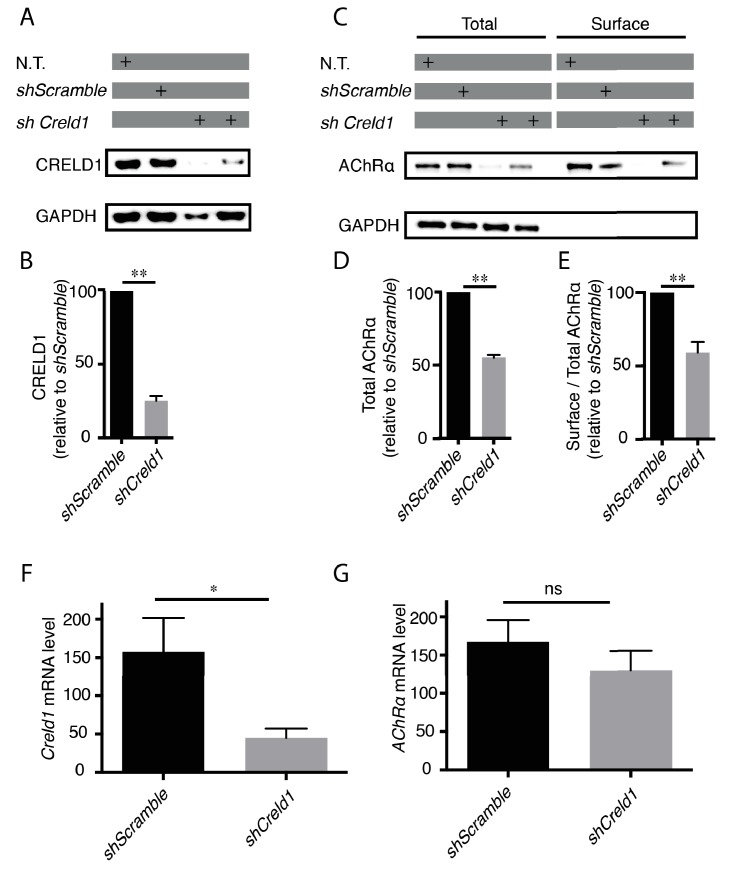
Creld1 knockdown leads to reduced AChR expression at the plasma membrane in vitro.(A–E) Measurement of mouse CRELD1 and AChR α subunit protein levels. C2C12 cells expressing shRNA against Creld1 (shCreld1) or scrambled (shScramble) sequences were differentiated for 5 days and then subjected to surface labeling with αBT-biotin for AChRα. N.T. = non transfected cells. Streptavidin precipitates (surface) and total lysates were separated by SDS/PAGE and probed for indicated proteins (A and C). CRELD1 protein levels were reduced by 75% in cells expressing shCreld1 as compared to shScramble (B). Quantitation of total AChRα levels (D) and of the surface to total AChRα ratio (E) in shScramble (100%) and shCreld1 cells from n = 5 independent experiments. Error bars, SEM; **p=0,0079, Mann-Whitney test. (F–G) Measurement of mouse Creld1 and AChRα subunit mRNA levels. C2C12 cells expressing shScramble or shCreld1 were differentiated for 5 days and then subjected to RNA extraction. Quantitative real-time PCR measurements of mRNA levels for Creld1 (F) and AChRα subunit (G). Creld1 mRNA is decreased in shCreld1 cells compared to shScramble cells, whereas AChRα subunit mRNA is not significantly decreased in shCreld-1 cells. Mean ± SEM is shown in six independent experiments. *p=0,0411; p=0,4740, ns (not significant), Mann–Whitney test.